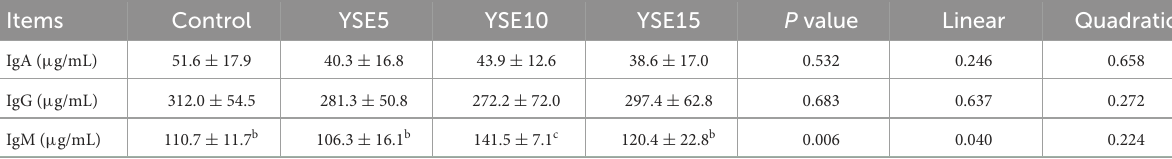
TABLE 5 Effects of supplemental different levels of YSE on serum immunoglobulins of young pigeons a . Items Control